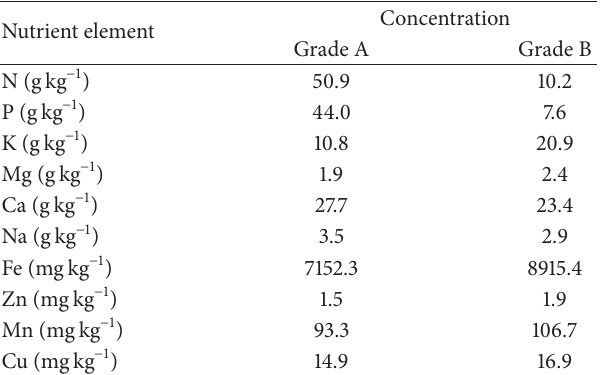
Table 1: Proximate analysis for organomineral fertilizer Grades A and